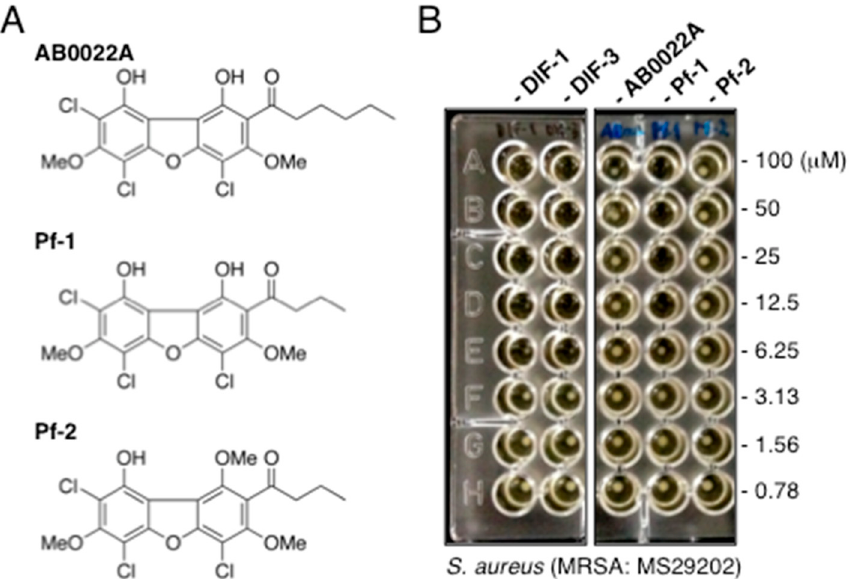
Figure 4. Effects of DIF derivatives on the ultracellular structure of S. aureus (MSSA). MSSA (ATCC29213) was incubated for 1.5 h at 37 °C in MHB in the presence of 0.2% DMSO (vehicle) or 4 µM of Ph-DIF-1, Ph-DIF-3, or Bu-DIF-3. The cells were collected, treated as described in the Materials and Methods section, and observed under a transmission electron microscope. Two representative photos of the DMSO-treated control MSSA and two representative photos of each DIF-treated MSSA are shown. The DIF-treated MSSA samples each show distinct multilayered structures composed of cell wall and/or plasma membrane.